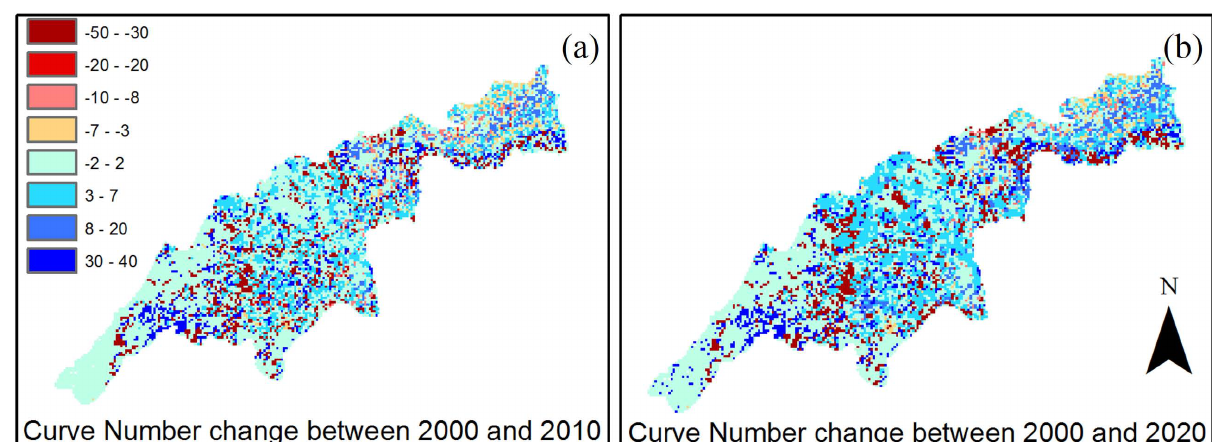
Fig. 8. Curve number estimated for different land uses.